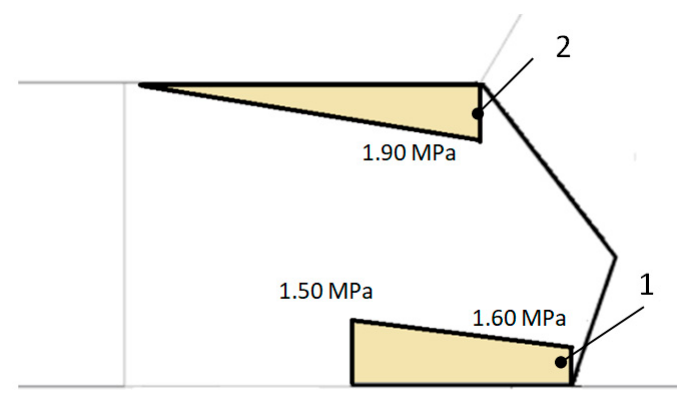
Figure 10. The distribution of load values along the roof (2) and floor (1) in the working of a longwall model.